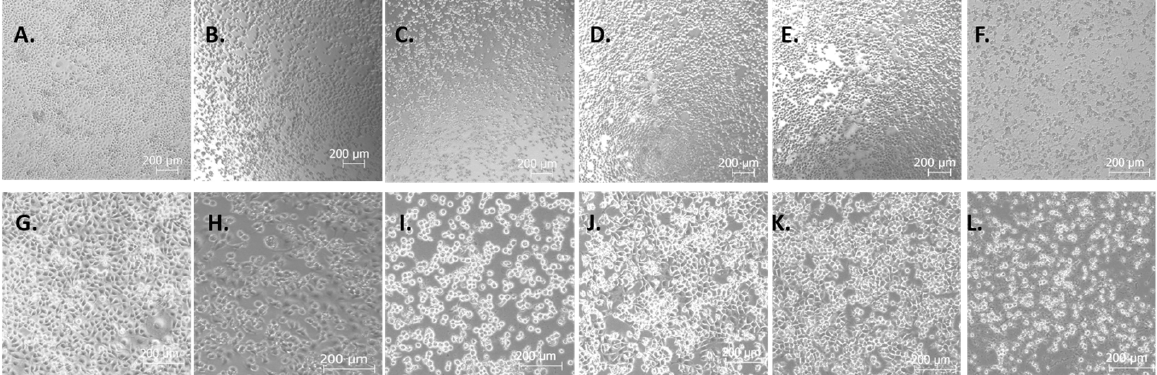
Figure 4. Analysis of apoptosis using propidium iodide (red) staining of MDA-MB-231 cells when treated with compound 2 ( left ), 8 ( center ), and 10 ( right ) at different doses, or vehicle for 48 h. Counterstain Hoersch (blue) was also used to image at 5×: ( A ) DMSO, ( B ) STS (2 μ M), ( C ) compound at 50 μ M, ( D ) compound at 25 μ M, ( E ) compound at 12 μ M. STS: Staurosporine. Previous studies have indicated a correlation between the anti-proliferative and an- tioxidant activities of natural products [23,24]; therefore, these compounds were tested using a ferric ion reducing antioxidant power (FRAP) assay [19,25]. Compounds 2 and 8 showed similar antioxidant potentials to the positive controls, while both compounds 7 and 9 displayed significant antioxidant potential (Figure 5). c on t r o l A b t